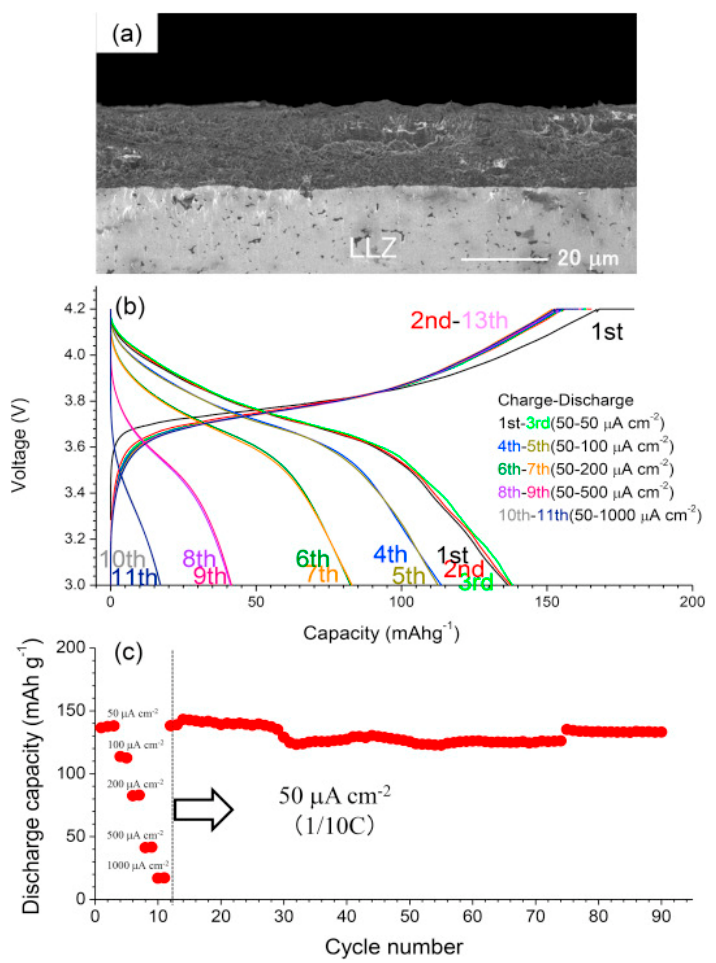
Figure 28. ( a ) Cross-sectional scanning electron micrograph of the LLZO/NMC-LATP composite